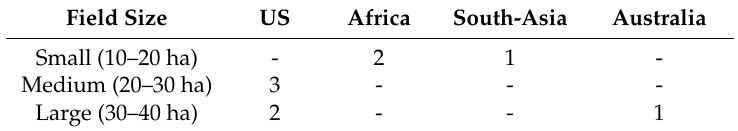
Table 1. Distribution of random study sites in different agriculture field sizes of different